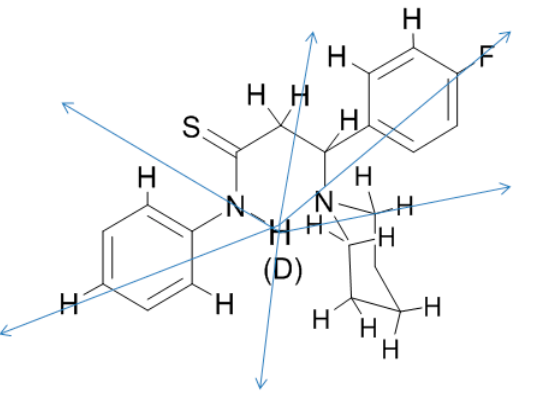
Figure 23. Example of electric field isotope effect through space in N-substituted 3-(cycloamino)-